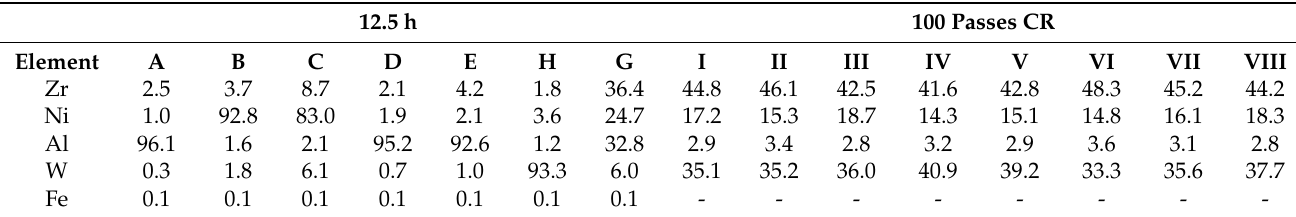
Figure 3. ( a ) A micrograph of the field-emission scanning electron microscope (FE-SEM) for the powders obtained after 12 h MA, ( b ) a photo of a dumbbell-shaped SUS304 vial filled with the powders and sealed under He gas atmosphere prior to the CR process, and ( c ) an FE-SEM micrograph of the powders after CR for 100 passes. The red circular symbols displayed in ( a , c ) refer to the zones selected for local elemental analysis via SEM/energy-dispersive X-ray (EDS) spectroscopy. The corresponding EDS results of the zones A-H and I-VIII are listed in Table 1 Table 1. Local elemental EDS analysis (at. %) of (Zr 70 Ni 25 Al 5 ) 65 W 35 powders obtained after 12.5 h of ball milling and 100 passes of cold rolling. 12.5 h 100 Passes